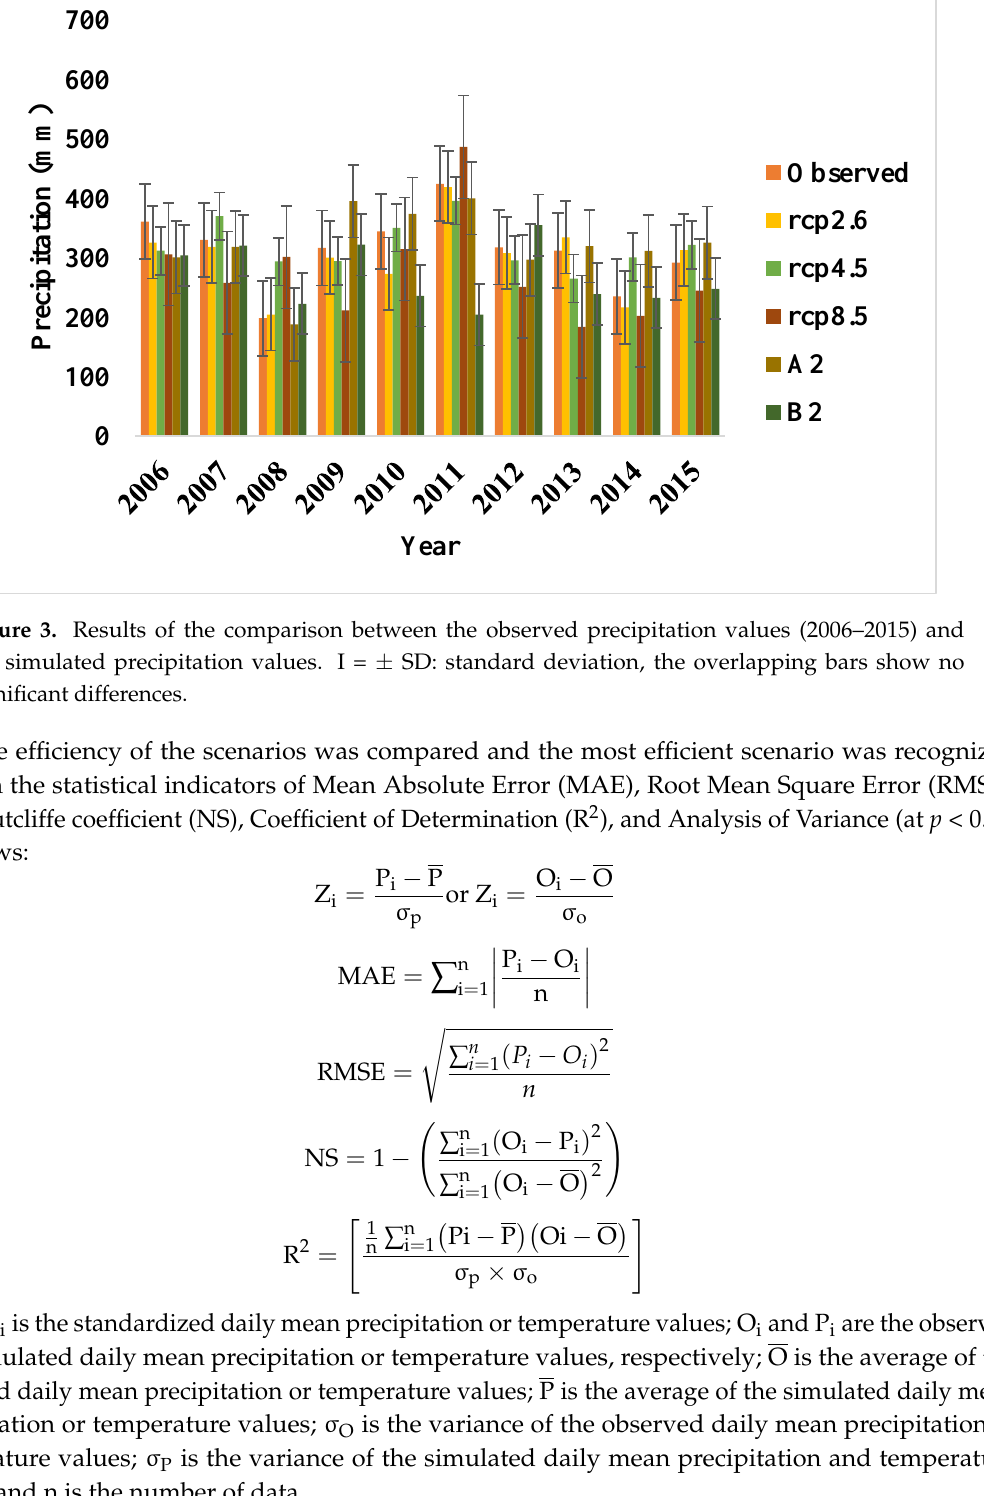
Figure 2. Results of the comparison between the observed and simulated monthly mean temperature values (2006–2015).